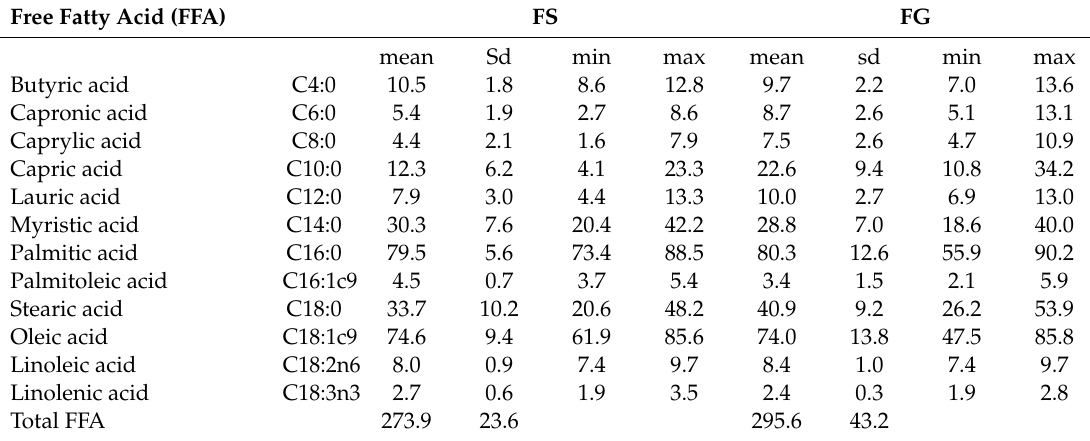
Table 4. Descriptive statistics of free fatty acid content (mg / 100 g of cheese) in Fruhe cheese produced with sheep (FS) and goat milk